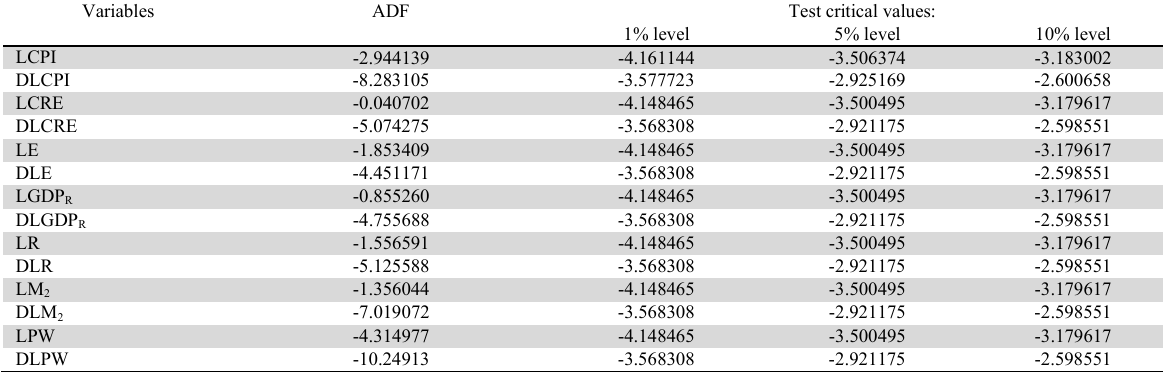
Verification of stopping of variables by ADF